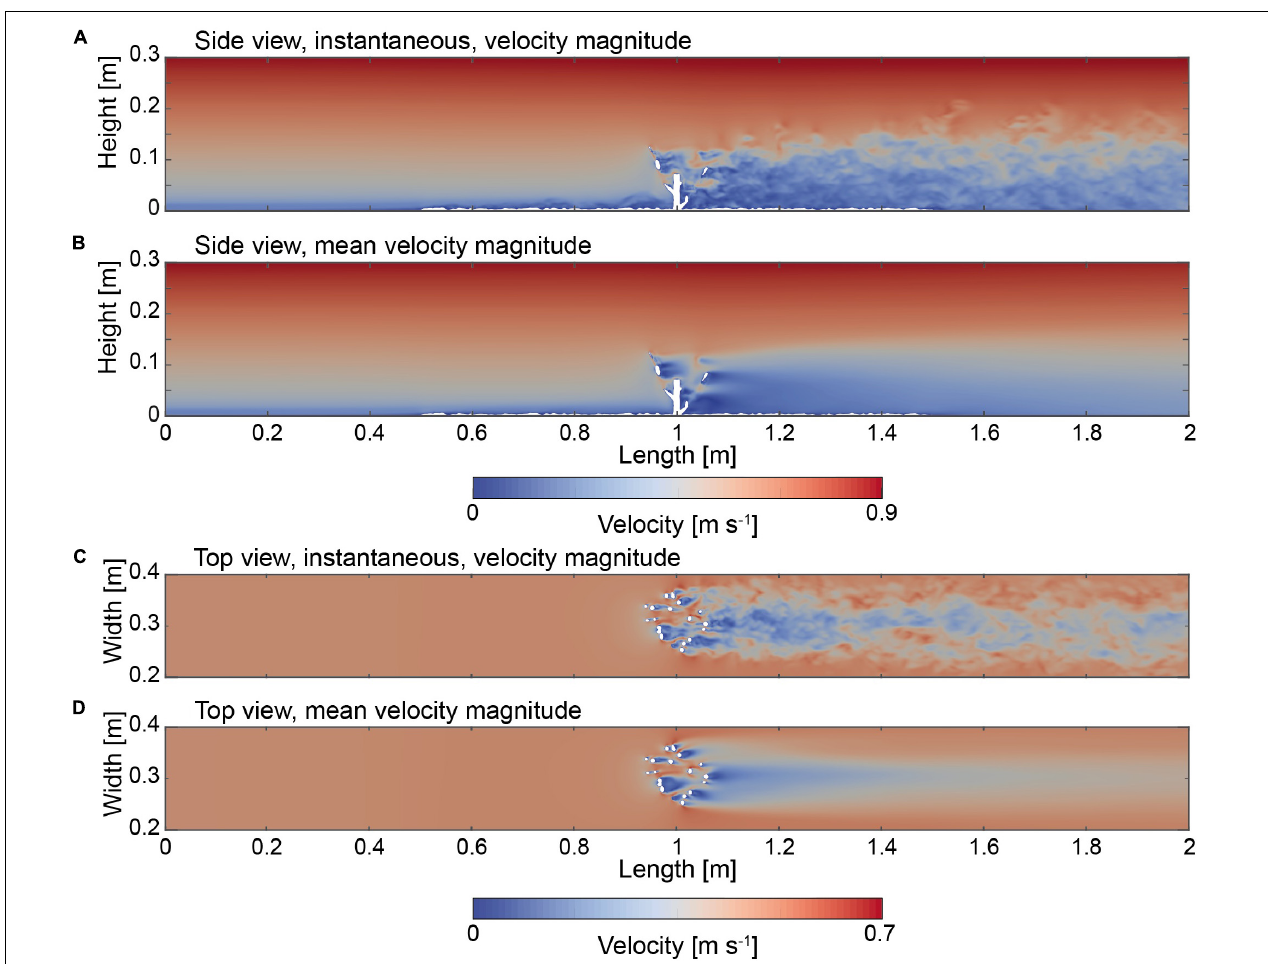
FIGURE 5 | (A) Side view ( Y = 0.15 m) indicating the instantaneous flow field at 25.0 s. (B) Side view ( Y = 0.15 m) of the time averaged flow field. (C) Top view ( Z = 0.05 m) indicating the instantaneous flow field at 25.0 s. (D) Top view ( Z = 0.05 m) of the time averaged flow field.